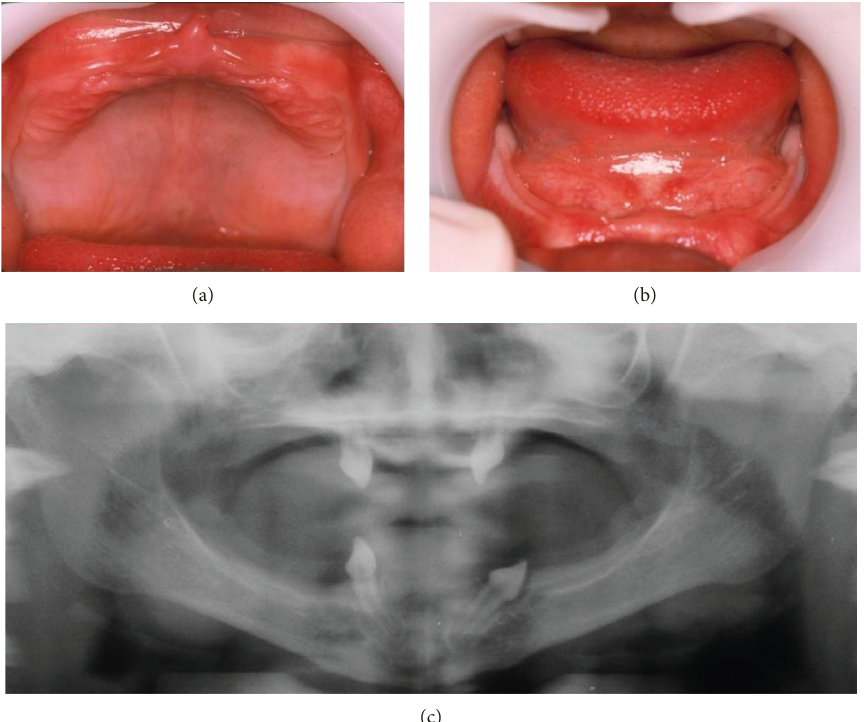
Figure 7: Patient 3. (a) Upper and (b) lower alveolar ridges were edentulous and underdeveloped, and (c) radiographic images showing the presence of the 53rd, 63rd, 73rd, and 83rd